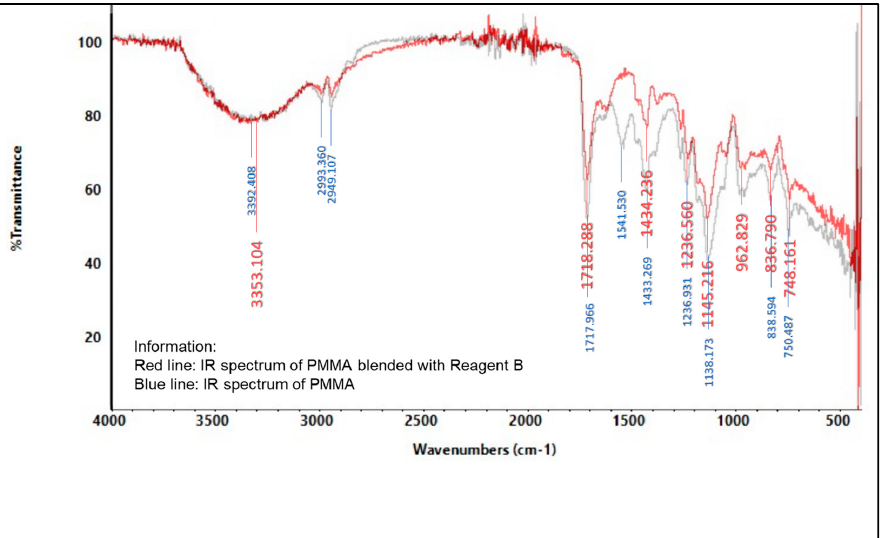
Figure 5. IR spectrum comparison of pure PMMA and blended PMMA with reagent B (concentrated HCl).